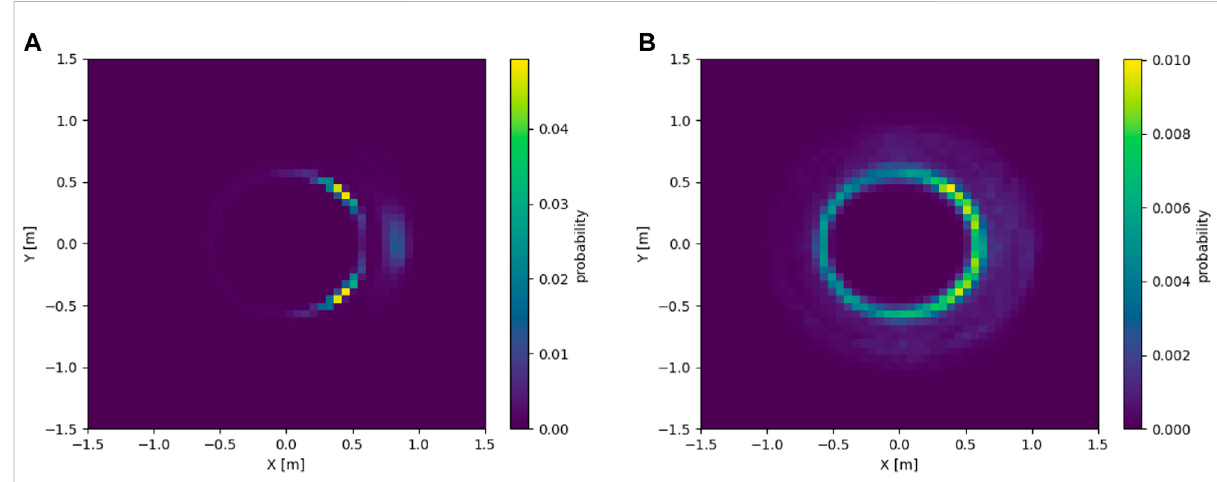
FIGURE 9 (A) PDFofneighborpositionsforastatic fl ockoffourrobots(simulatedusing μ M-A),fromthepointofviewofarobotplacedat(0,0)facingeast. (B) PDF of neighbor positions for a fl ock of four robots tasked to follow an 8-shape trajectory (simulated using μ M-A), from the point of view of a robot placed at (0,0) facing east.